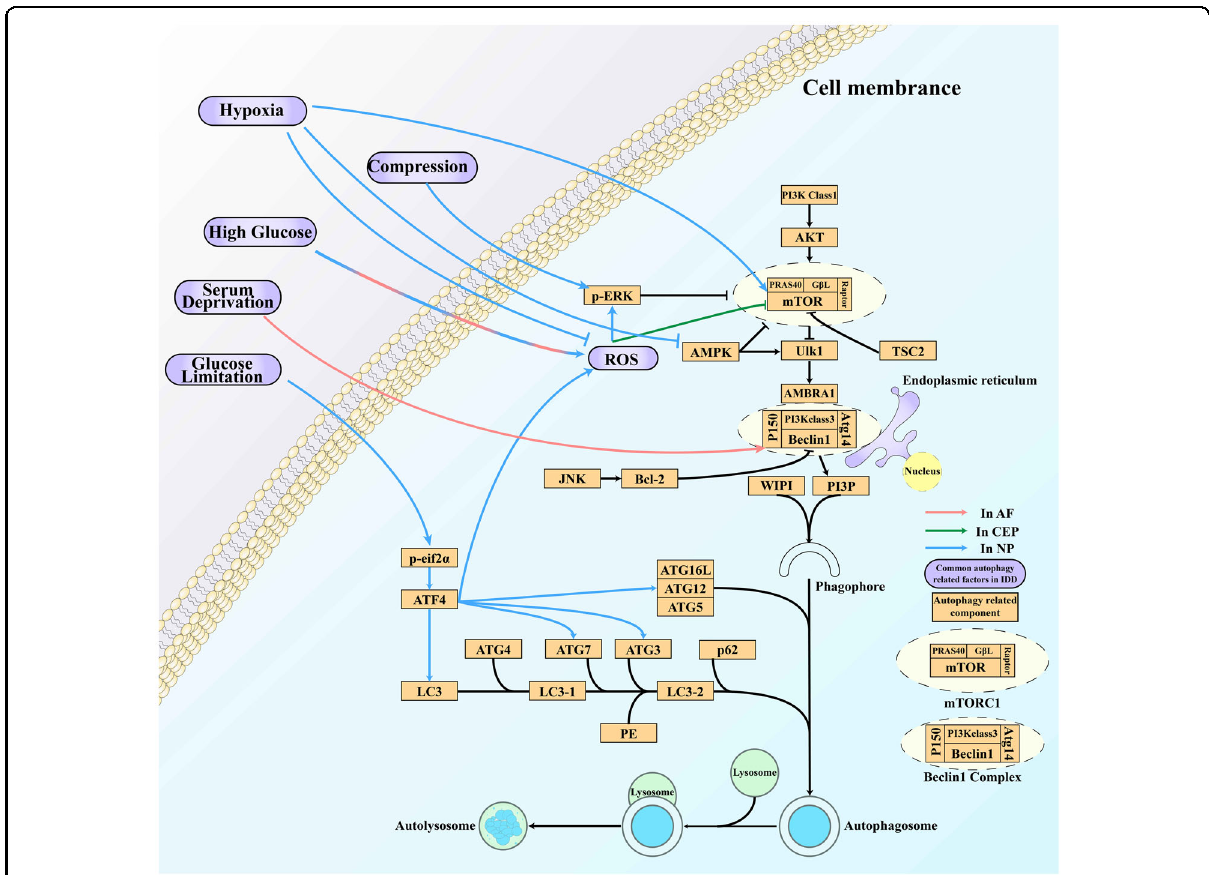
Fig. 2 Autophagy in intervertebral disc degeneration. Compression, high glucose levels, serum deprivation, and glucose limitation are common stimuli that activate autophagy in IVDs through different pathways and play various roles in IDD. In contrast, hypoxia inhibits autophagy through the classic autophagy pathway in NPCs. ROS are factors involved in high glucose-, serum deprivation- and hypoxia-dependent autophagy regulation that downregulate mTOR